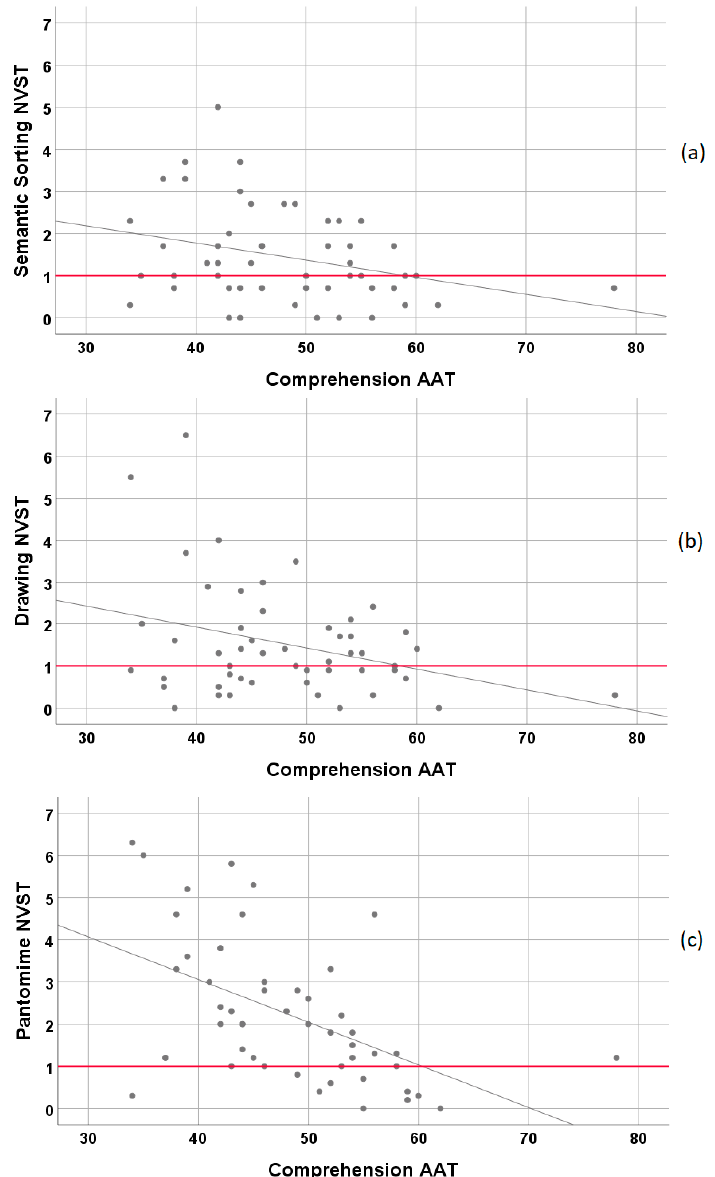
Figure 2. Relationship of NVST subtests with subtest Comprehension of the AAT. ( a ) Semantic Sorting vs. Comprehension, ( b ) Drawing vs. Comprehension, and ( c ) Pantomime vs. Comprehension. For correlation coefficients see Table 2.